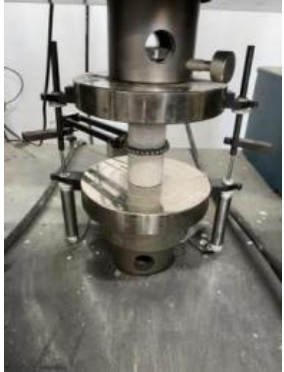
Figure 3. Single-axis cyclic loading and unloading tester.